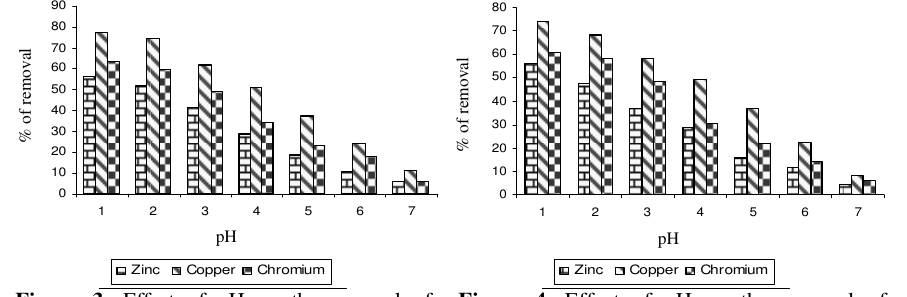
Figure 3. Effect of pH on the removal of Zn(II), Cu(II) and Cr(VI) by sawdust. Powder. Condition: T = 23 o C and t = 60 minutes